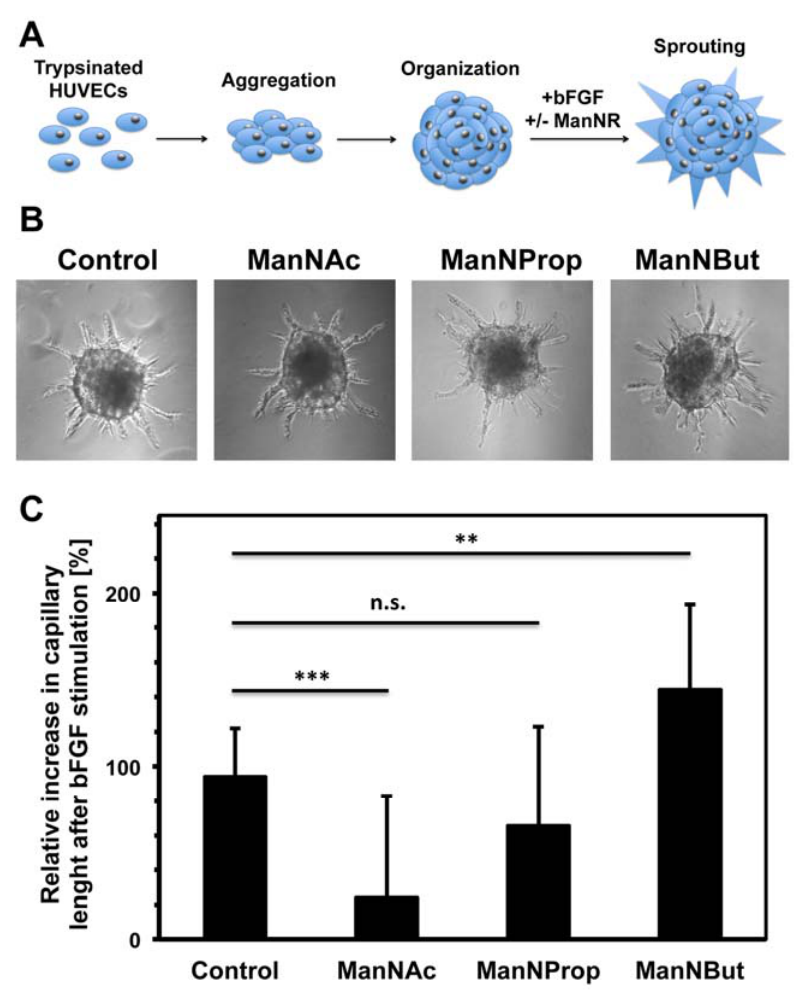
Figure 6. Influence of per- O -acetylated ManNR derivatives on capillary sprouting of endothelial cell spheroids induced by bFGF. ( A ) Scheme of the applied three dimensional angiogenesis assay. HUVECs spheroids were treated with bFGF to induce capillary sprouting in absence (control) or presence of indicated sialic acid precursor molecules (R, acyl chains) [13,14]. (B) Representative spheroids after bFGF stimulation. ( C ) The lengths of arising capillaries were measured and obtained values were summed up using NIS Elements AR 3.0 Software (Nikon, Düsseldorf, Germany). Results are shown as relative increase in total capillary length after stimulation with bFGF. To this end, total capillary lengths of spheroids were measured after bFGF stimulation and compared with the unstimulated control. All values ± S.D. in this figure are means of 3 independent experiments using at least 12 spheroids per set. The statistical evaluation was performed by Student´s t test (unequal variances, two tailed). Significance levels are indicated by n.s. (not significant), p > 5%; *, p < 5%; **, p < 1%; ***, p <